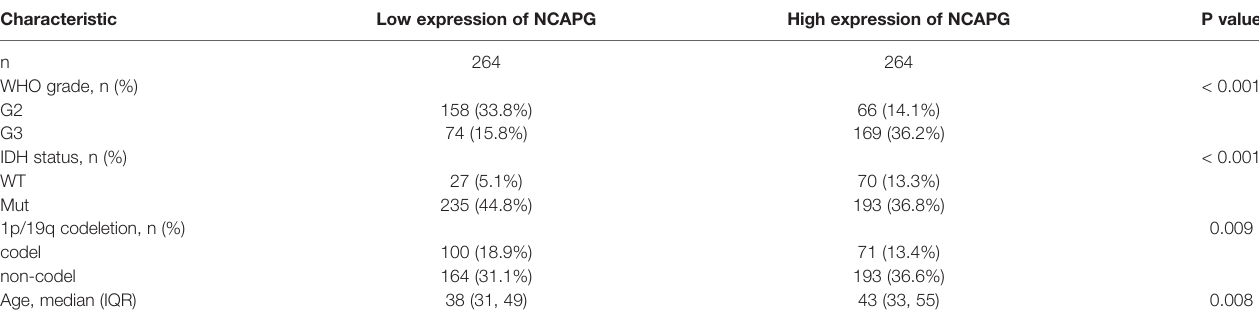
TABLE 1 | The correlation between NCAPG and clinicpathologic characteristic in TCGA-glioma dataset. Characteristic